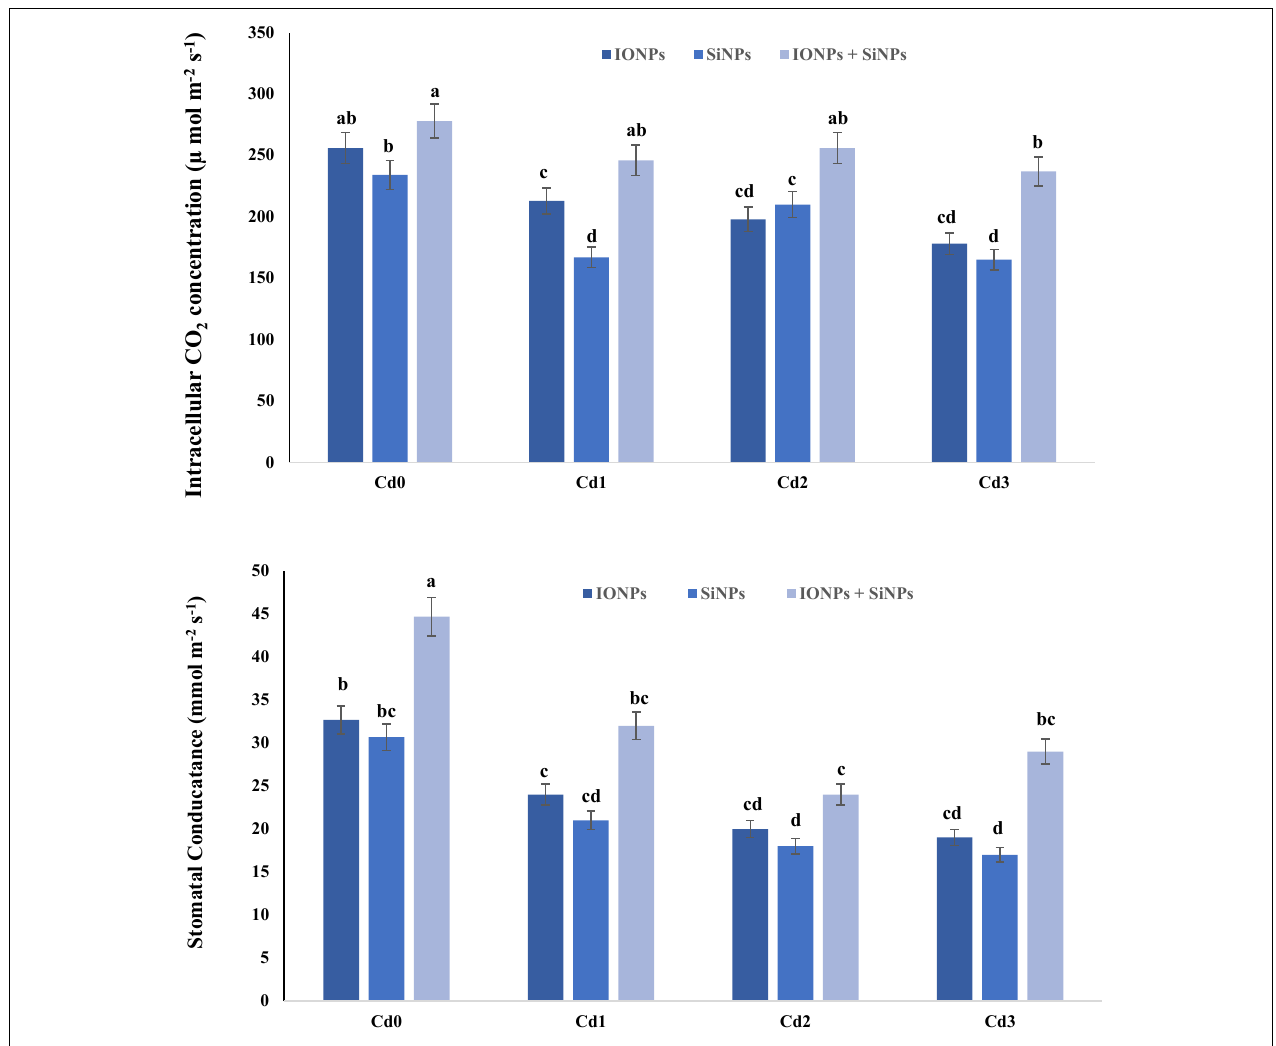
FIGURE 1 | Effect of IONPs and SiNPs on intercellular CO 2 concentration and stomatal conductance of Phaseolus vulgaris grown in different concentrations of Cd. Here IONPs, SiNPs, Cd0, Cd1, Cd2, and Cd3 indicate iron oxide nanoparticles, silicon nanoparticles, 0 mM CdCl 2 , 1 mM CdCl 2 , 1.5 mM CdCl 2 , and 2 mM CdCl 2 . Different letters indicate significant difference among the treatments ( P ≤